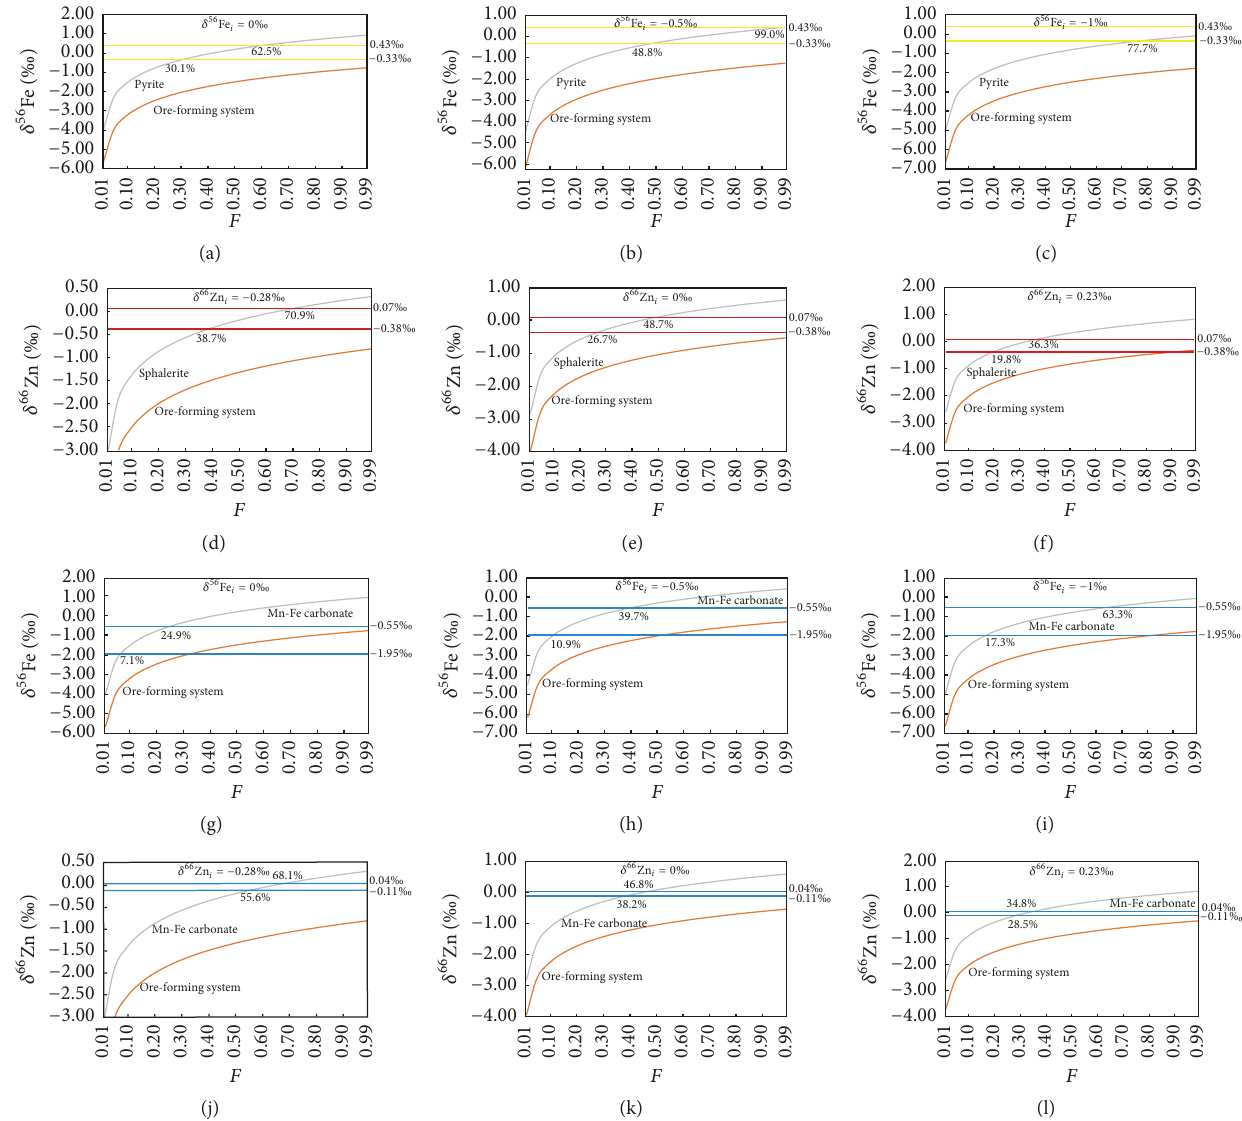
Figure 8: The Fe-Zn isotopic fractionation models for the ore-forming system and minerals (pyrite, sphalerite, and Mn-Fe carbonate) with different 𝛿 56 Fe 𝑖 and 𝛿 66 Zn 𝑖